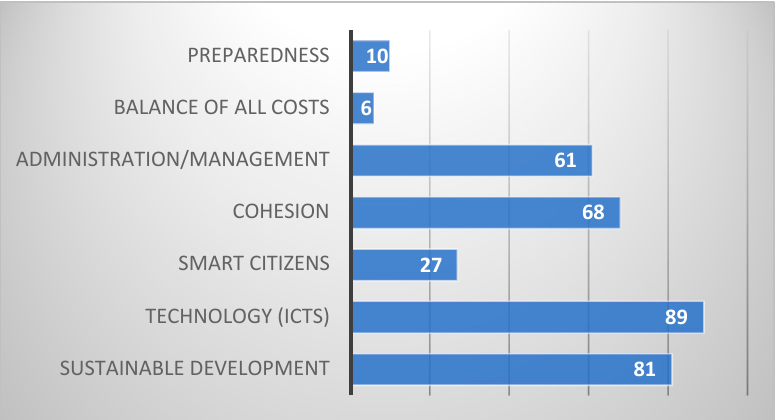
Figure 2. Key factors for an SC according to the respondents familiar with the SC concept (%). Due to the multiple-choice question, the answers do not sum up to 100%. Source: own elaboration.